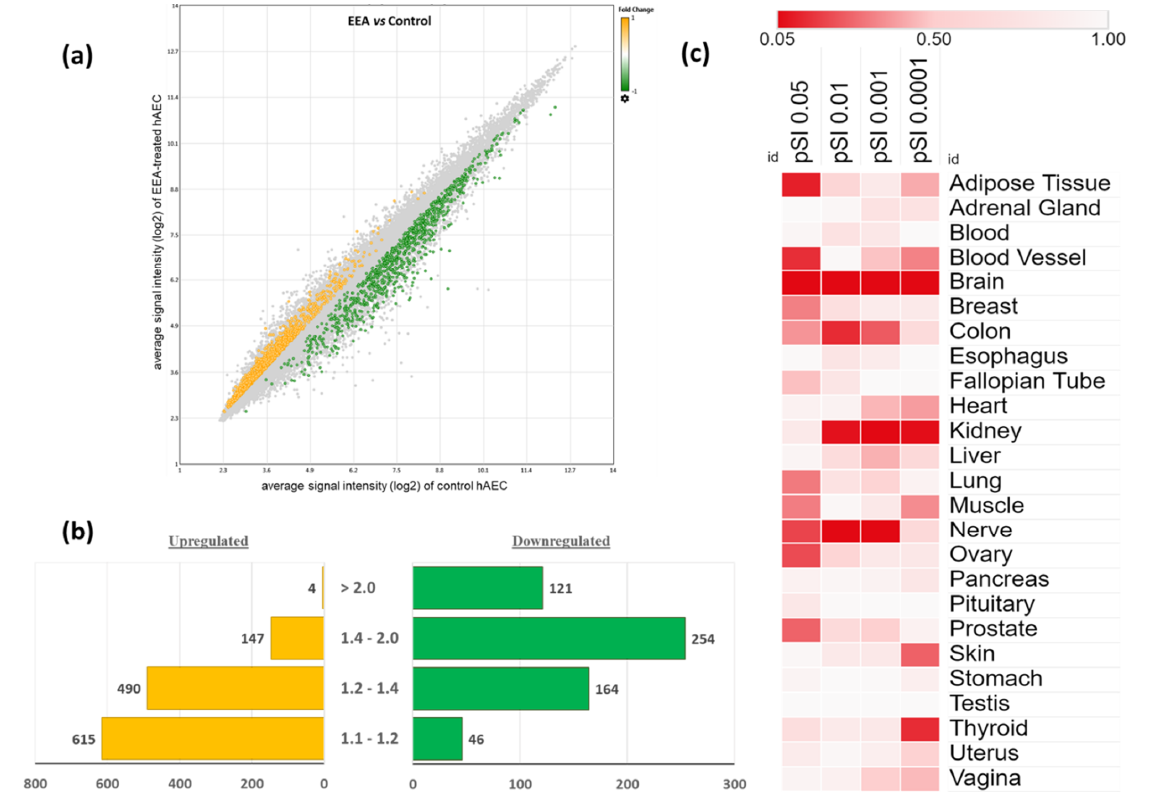
Figure 1. Microarray gene expression profile of squalene-rich ethanol extract of Aurantiochytrium 18W-13a (EEA-SQ)-treated human amniotic epithelial cells (hAECs). ( a ) Scatter plot showing the differentially expressed genes (DEGs) between EEA-SQ-treated and control hAECs. The X-axis dis- plays the average signal intensity (log2) of genes in EEA-SQ-treated hAECs and Y-axis corresponds to the average signal intensity (log2) of genes in control hAECs. Up and downregulated DEGs are presented in the yellow and green dots, respectively. ( b ) Bar graph displays the number of DEGs and distribution of fold changes. ( c ) Heat map showing the significance and specificity of the ex- pressions of the DEGs across 25 tissues. Enrichment analysis was conducted using the Tissue-Spe- cific Expression Analysis (TSEA) tool (http://genetics.wustl.edu/jdlab/tsea//, accessed on 14 October 2021). Heat map was generated on Morpheus tool (https://software.broadinstitute.org/morpheus//, accessed on 28 October 2021). 3.2. Tissue-Specific Enrichment Analysis of the Differentially Expressed Genes (DEGs) Enrichment analysis of the expressions of the DEGs across 25 tissues was performed using the TSEA web tool (Figure 1c). Among the DEGs (n = 1841), 1703 genes were found to be expressed in at least one tissue. We found that the brain was the most significantly enriched tissue by the DEGs in all specificity index thresholds (pSI) varying from 0.005 to 0.0001. A total of 229 DEGs were brain-specific. Among them, 31 had the highest specific- ity threshold (pSI < 0.0001, p-value = 0.002), 35 had pSI < 0.001 ( p -value = 0.001), 64 had pSI < 0.01 ( p -value = 0.003), and 99 had pSI < 0.05 ( p -value = 0.007). Table 1 shows the overlapped genes with pSI < 0.0001 and their functions. Brain-specific DEGs are involved in chemical synaptic transmission, axon development, neurotransmitter secretion, re- sponse to wounding, axon ensheathment, locomotion, negative regulation of neuron apoptotic process, astrocyte development, glutamate secretion, long-term synaptic poten- tiation, and positive regulation of neurogenesis. The next significantly enriched tissue was the kidney. Several kidney-specific (pSI < 0.001) solute carrier genes were identified, responsible for ion transport. The skin and